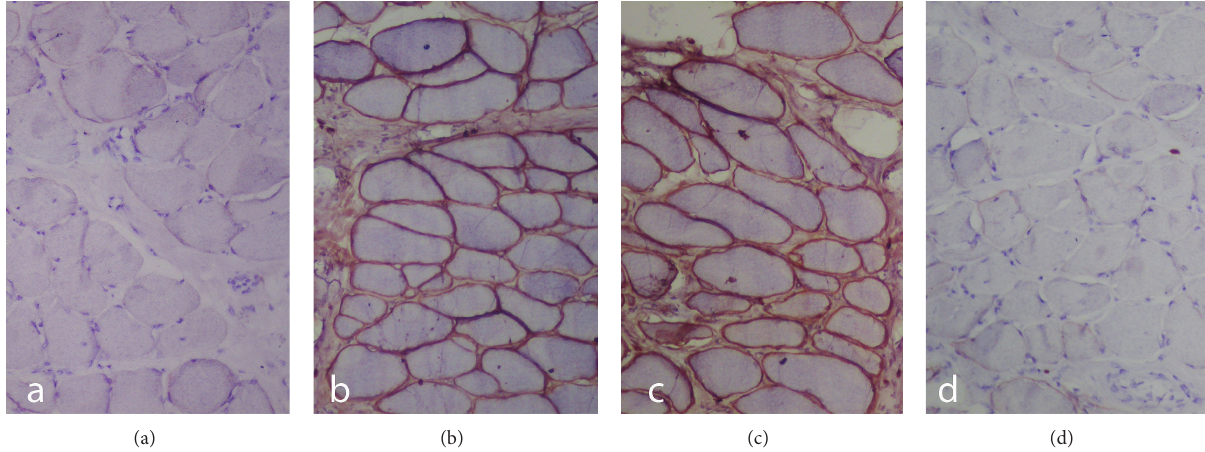
Figure 3: Diffuse absence of sarcolemmal 𝛼 -SGC (a) and 𝛾 -SGC (d) expression and normal 𝛽 -SGC (b) and 𝛿 -SGC (c) expression (DABx 200).